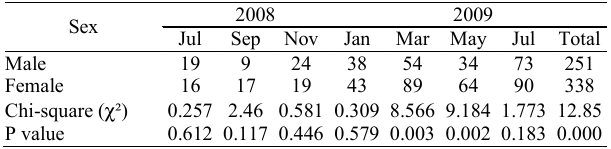
Table 3. Sex ratio for the catfish Auchenipterichthys longimanus collected in the Caxiuanã National Forest, Pará State, between July 2008 and July